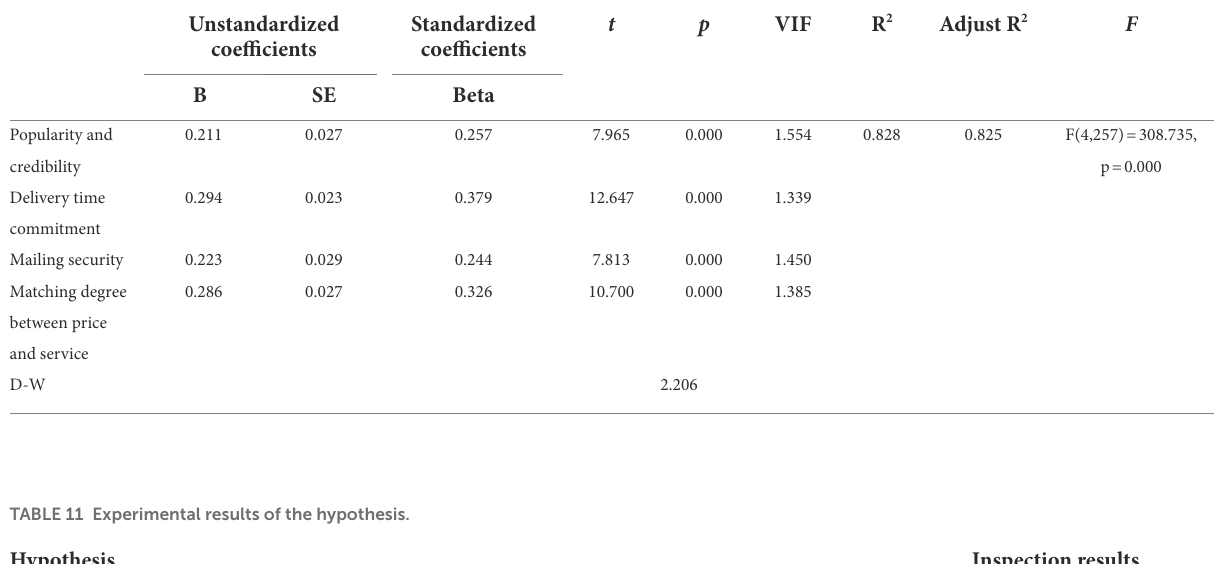
TABLE 10 Regression results of three-level indicators and perceived service quality reliability.